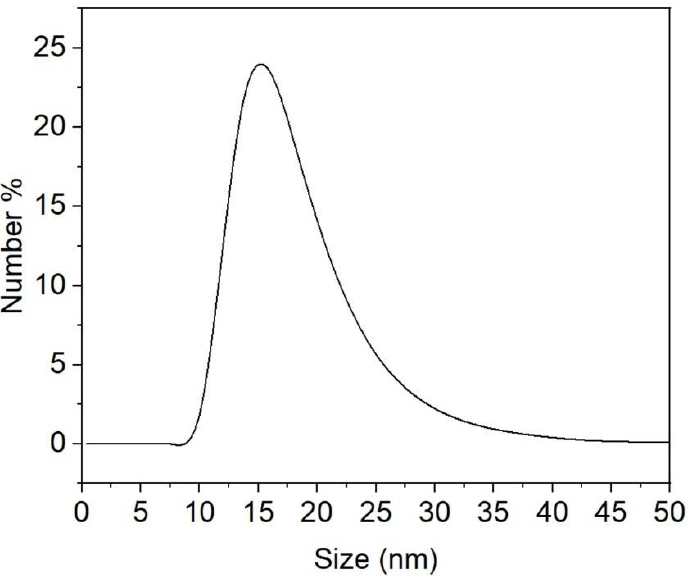
Figure 3. The size distribution of the functionalized chestnut-shell-extract AgNPs measured by DLS.